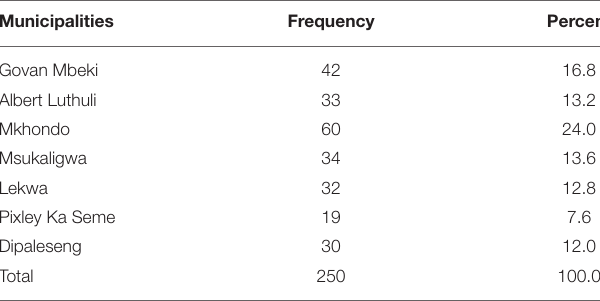
TABLE 1 | Sample size taken in each municipality